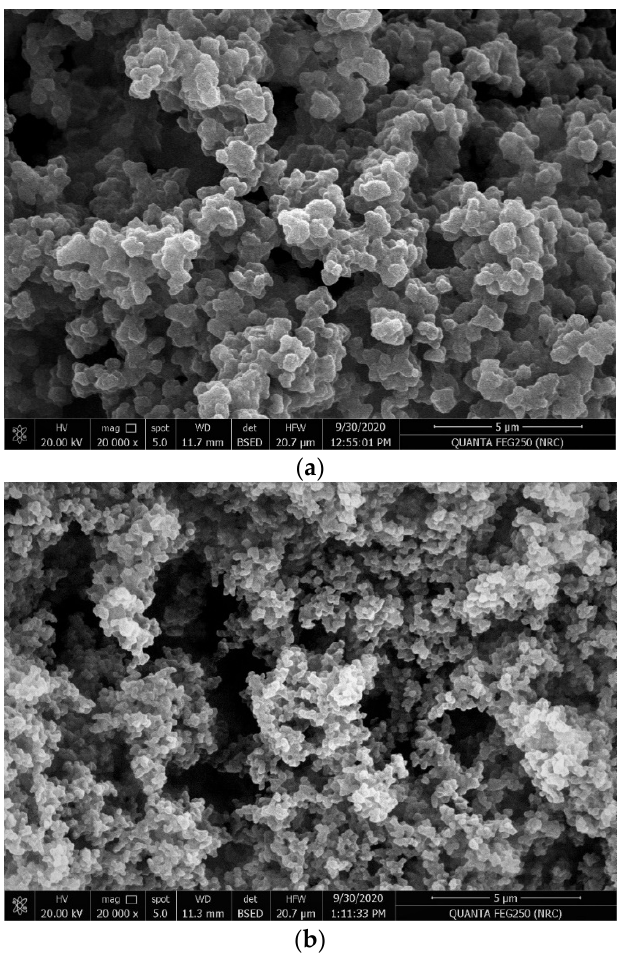
Figure 2. SEM images of ( a ) molecularly imprinted polymer (MIP) and ( b ) nonimprinted polymer (NIP) beads .